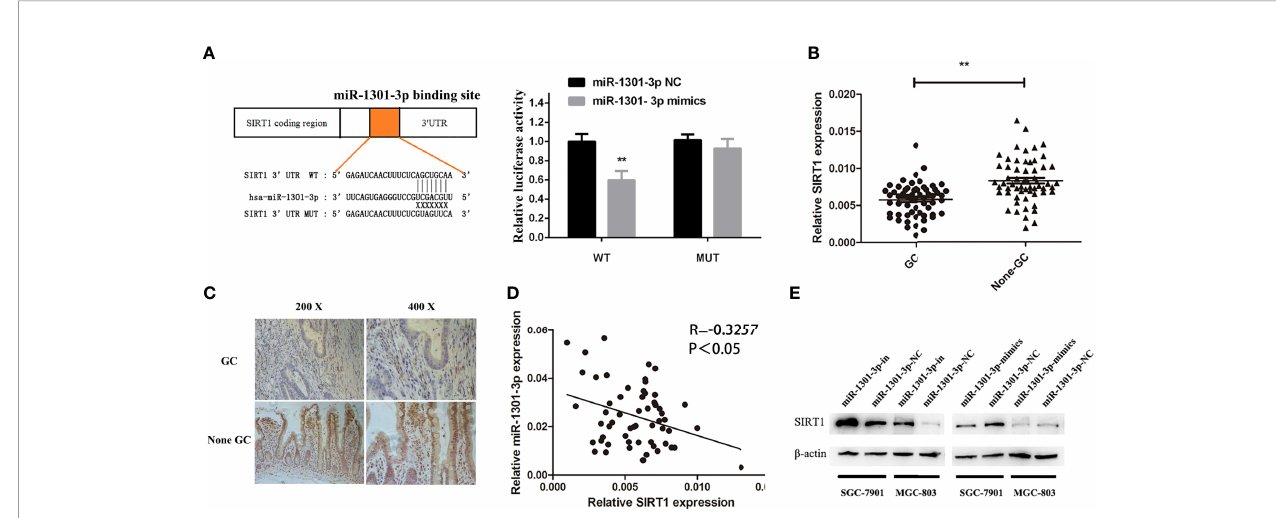
FIGURE 6 | SIRT1 was a direct target of miR-1301-3p in GC. (A) Luciferase reporter assay proved that SIRT1 was a direct target of miR-1301-3p. (B) The expression levels of SIRT1 in 60 pairs of GC and adjacent normal tissues. (C) IHC investigations showed decreased SIRT1 expression in GC tissues compared with that in the paired adjacent normal tissues. (D) There was a negative correlation between the expression of miR-1301-3p and SIRT1 in GC specimens. (E) Overexpression of miR-1301-3p inhibited SIRT1 protein expression, knockdown of miR-1301-3p could promote SIRT1 protein expression. **p <